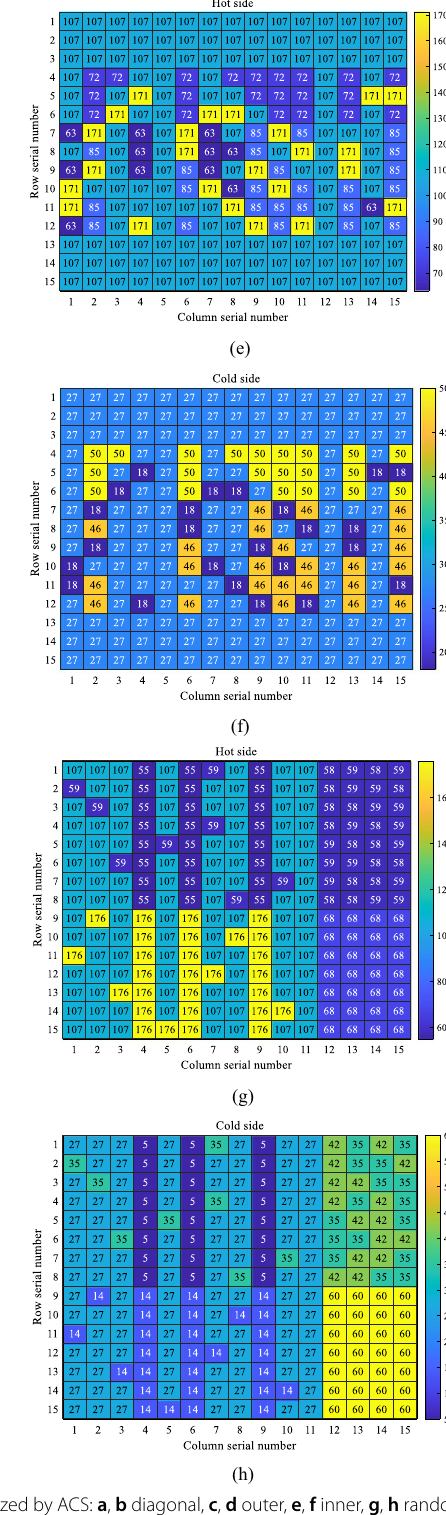
Fig. 6 Temperature distribution (°C) of four different scenarios for (15